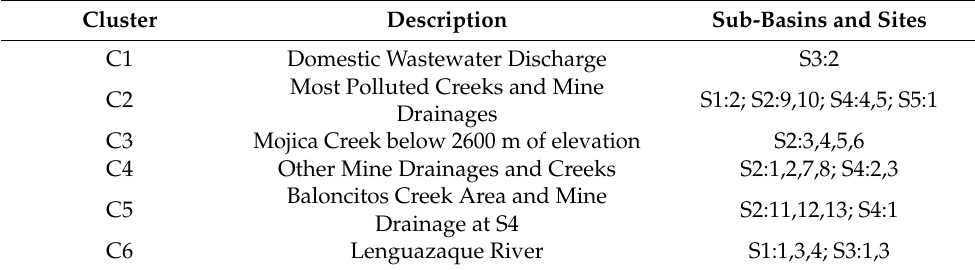
Table 4. Clusters of sites with similar water quality.